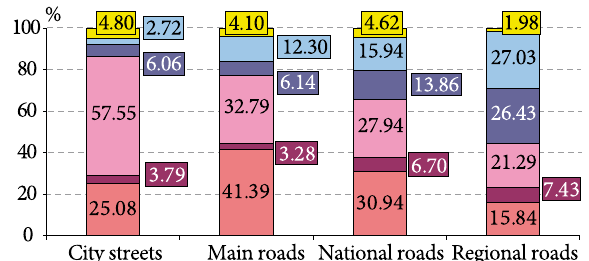
Fig. 7. Distribution of accident types within the road